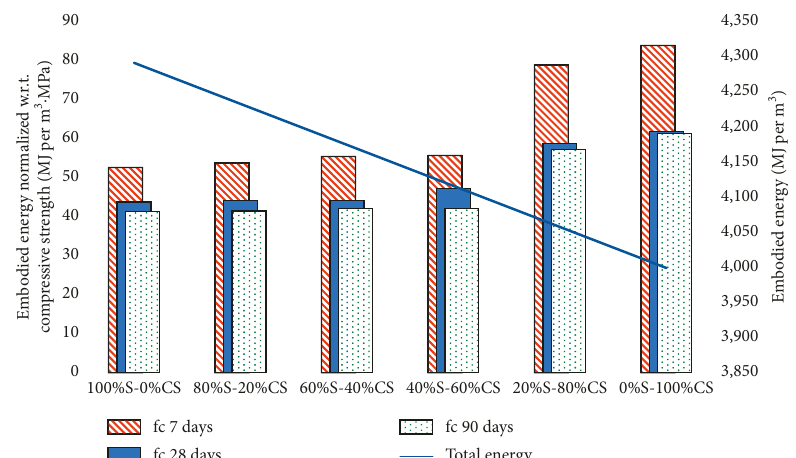
Figure 10: Normalized embodied energy of concrete mixes with respect to their compressive strengths at varying curing ages, Green- Concrete LCA tool [3].